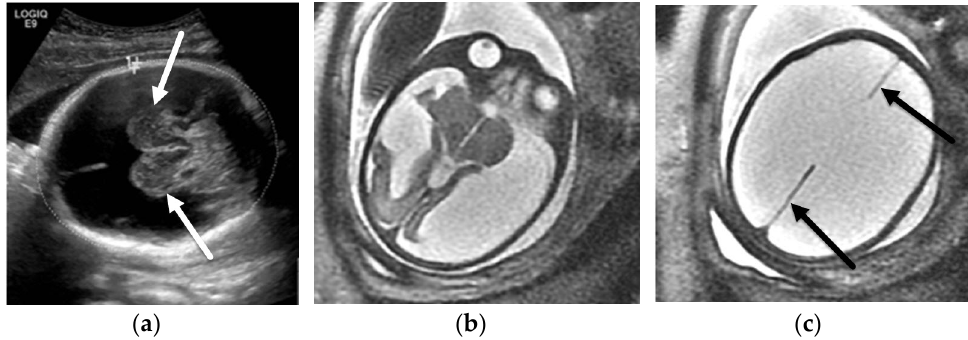
Figure 4. Hydranencephaly. A 35-week, 6-day GA fetus referred for ventriculomegaly on screening ultrasound. Axial ultrasound image ( a ) through the head demonstrates near complete absence of the cerebral hemispheres with relative sparing of the thalami (arrows). Axial T2-SSFSE images through the fetal brain ( a , b ) confirm fetal ultrasound findings with near complete absence of the cerebral hemispheres with relative sparing of the thalami and temporo-occipital lobes consistent with hydranencephaly. There is perseveration of the falx cerebri (( c ), arrows), which is characteristic of this diagnosis.